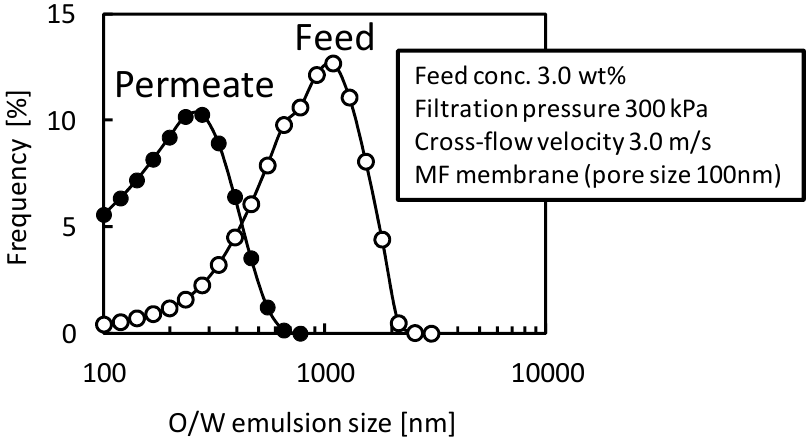
Figure 6. Size distributions of O/W emulsion in feed and permeate suspensions in the filtration with the MF membrane (nominal pore size 100